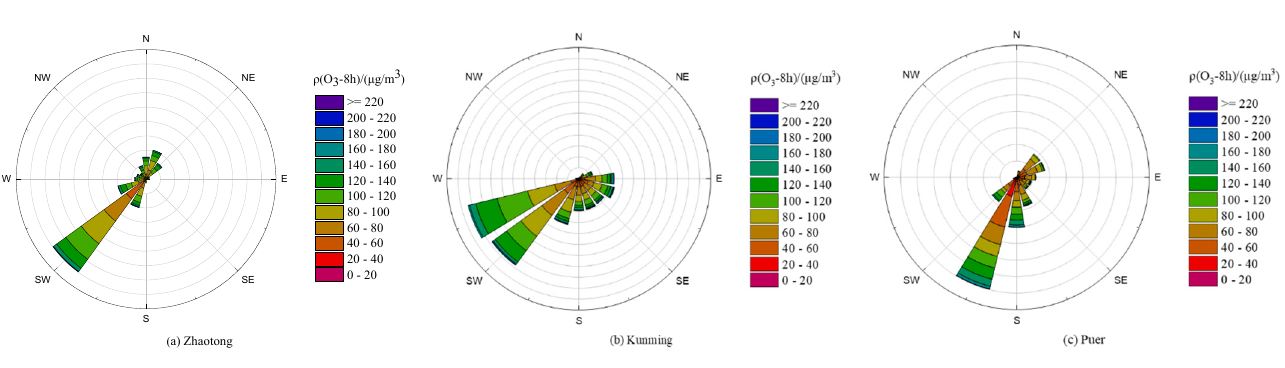
Figure 10. Changes from O 3 Concentration and wind rose illustration, exceeding standard frequency between Zhaotong, Kunming and Pu’er.